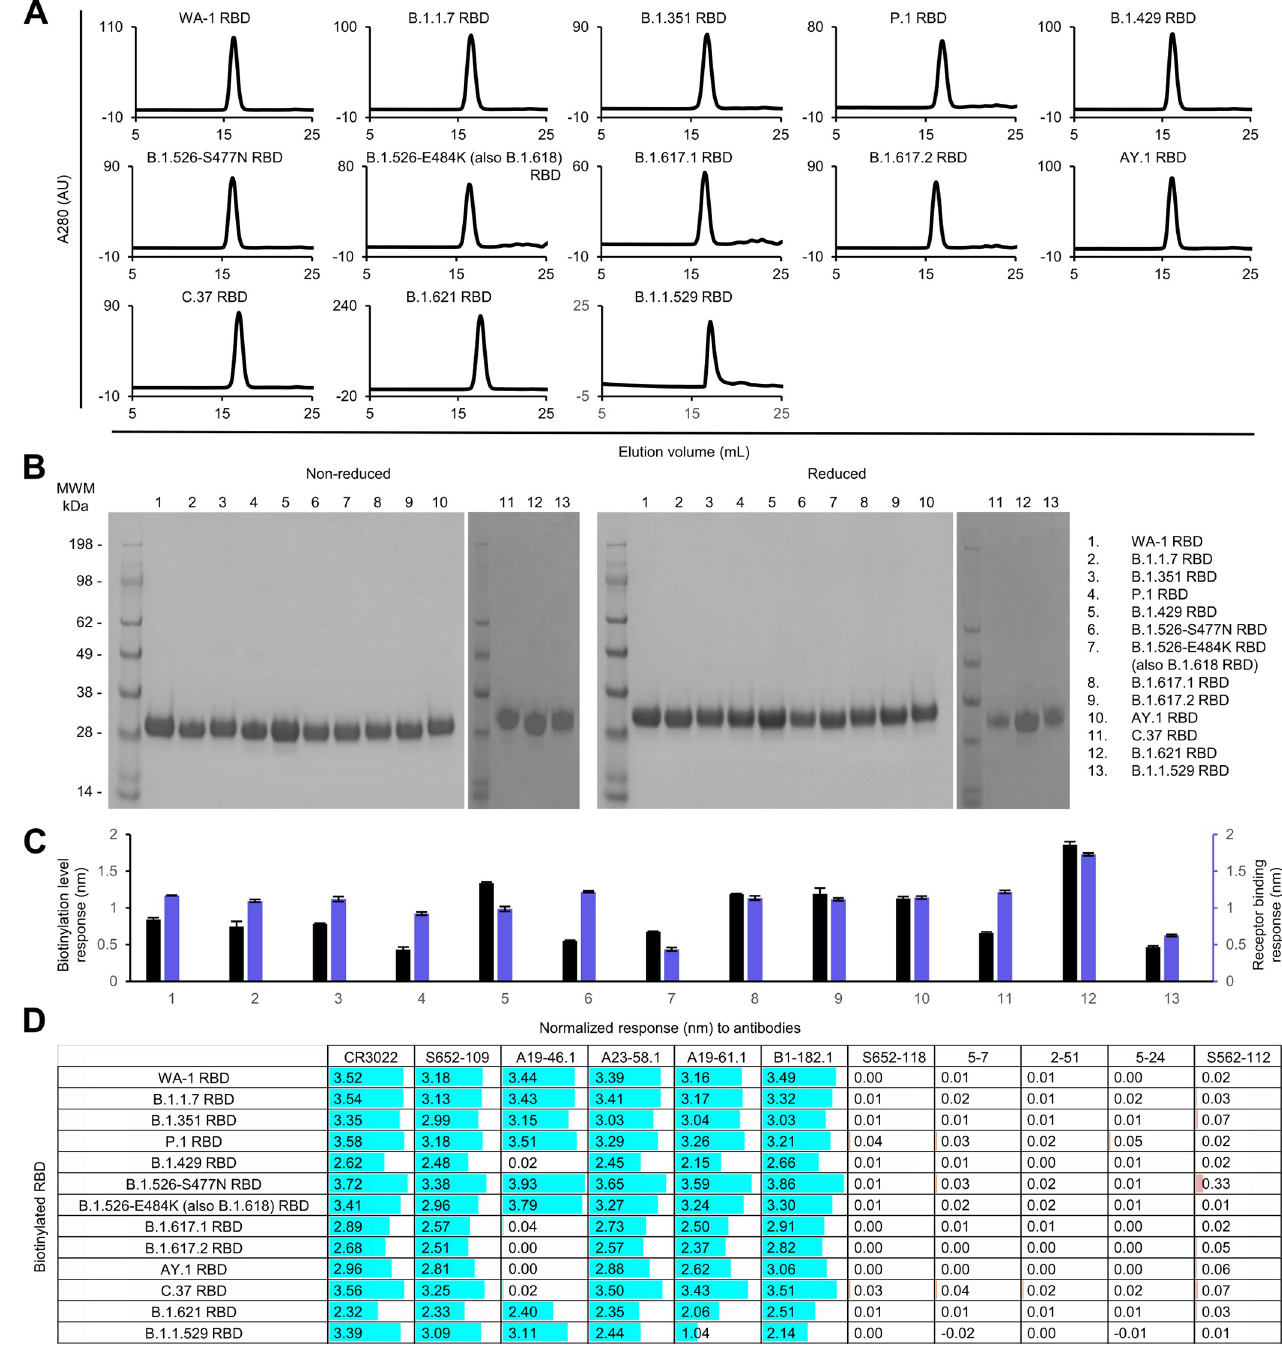
Fig 6. Characterization of biotinylated SARS-CoV-2 variant RBD probes confirms their homogeneity and antibody-binding specificity. (A) Size exclusion chromatography of the purified biotinylated SARS-CoV-2 RBD probes, including WA-1 RBD and 12 other variant RBD probes, in PBS buffer. (B) SDS-PAGE of SARS-CoV-2 RBD variant probes with and without reducing agent. Molecular weight marker (MWM) and the WA-1 RBD probe were run alongside the variant RBD probes. (C) Biotinylation and receptor recognition of the SARS-CoV-2 variant RBD probes. The level of biotinylation was evaluated by capture of the RBD probes at 2.5 μ g/ml onto the streptavidin biosensors using Octet. Receptor binding was assessed with 500 nM of dimeric ACE2. Error bars represent standard deviation of triplicate measurements. (D) Antigenicity assessment of the SARS-CoV-2 variant RBD probes. Responses to RBD-directed, NTD- directed, and S2 subunit-directed antibodies were shown in cyan, orange, and rose, respectively. Bar scale between 0 and 4. Variants with the L452R mutation did not binding antibody A19-46.1.